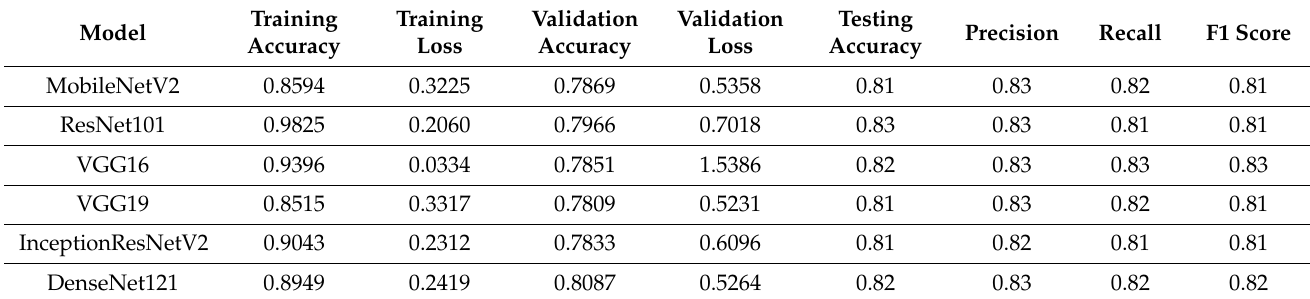
Table 4. Results of different classifiers on Dataset II containing 2 classes.